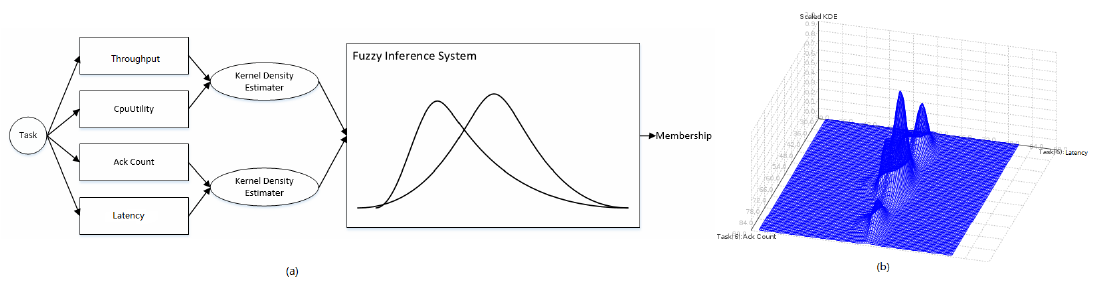
Figure 5. Bottleneck detector: ( a ) Fuzzy Inference System ( b ) Kernel Density